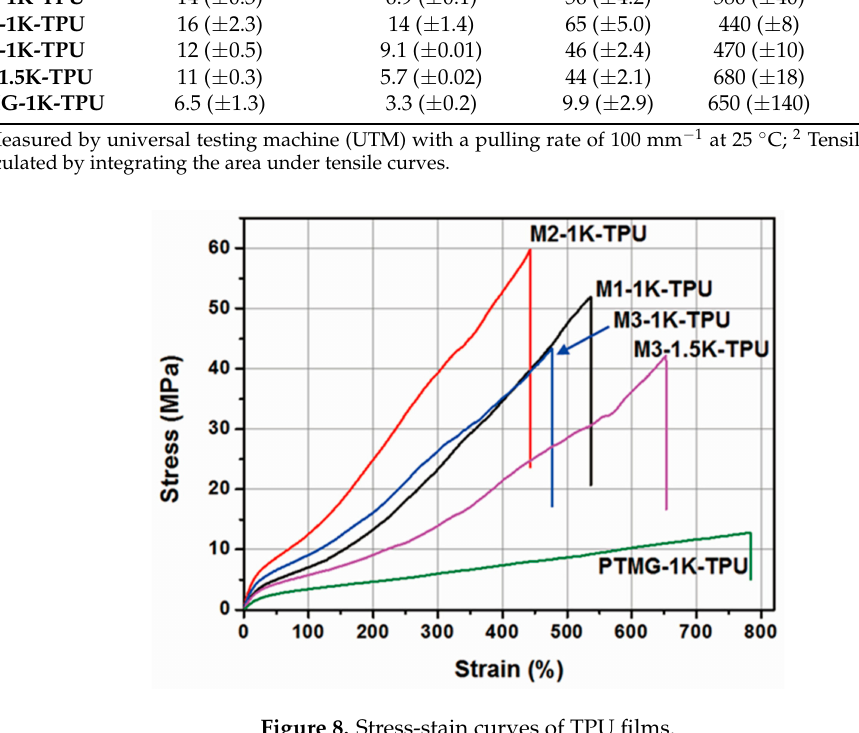
Figure 8. Stress-stain curves of TPU